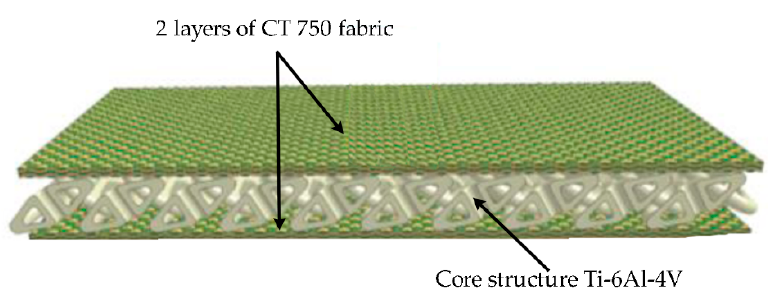
Figure 2. Configuration of the analyzed ballistic insert.